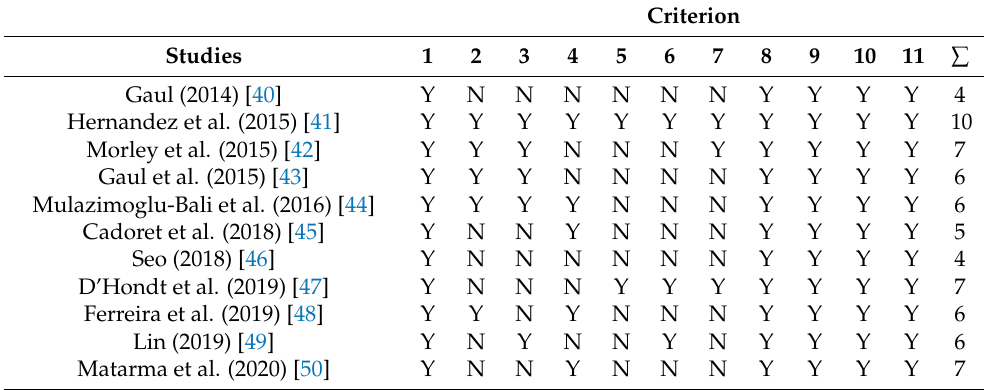
Table 1. PEDro scale for cross-sectional studies.